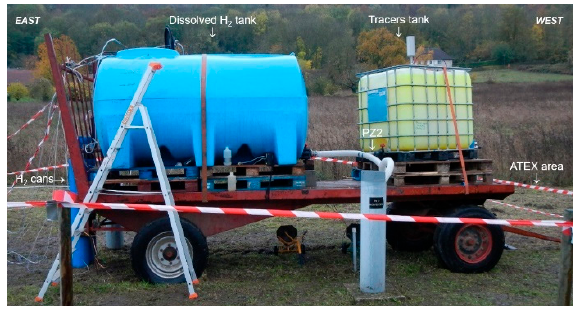
Figure 5. View of the injection device.